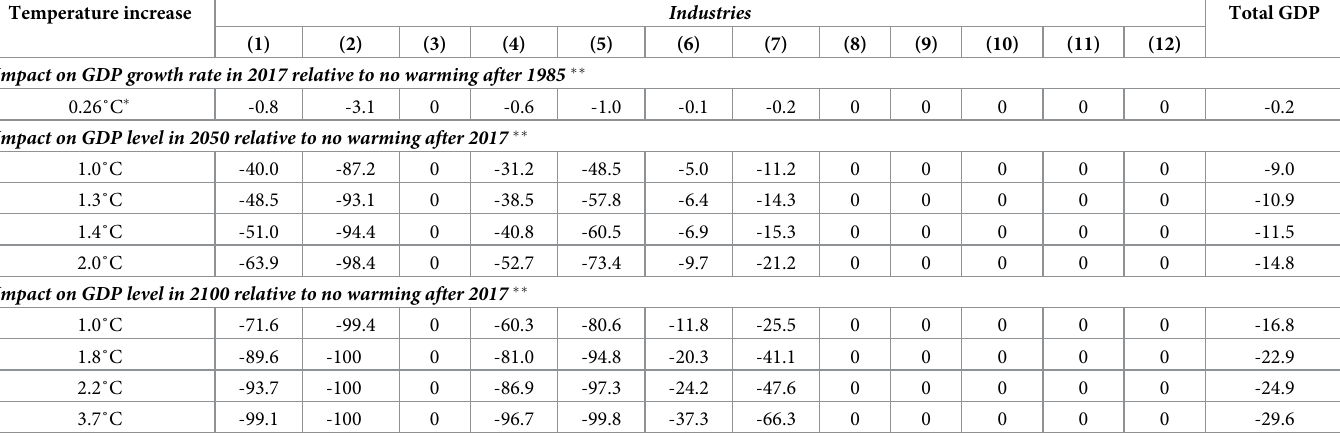
Notes : � Global temperature increase over the period 1985–2017.